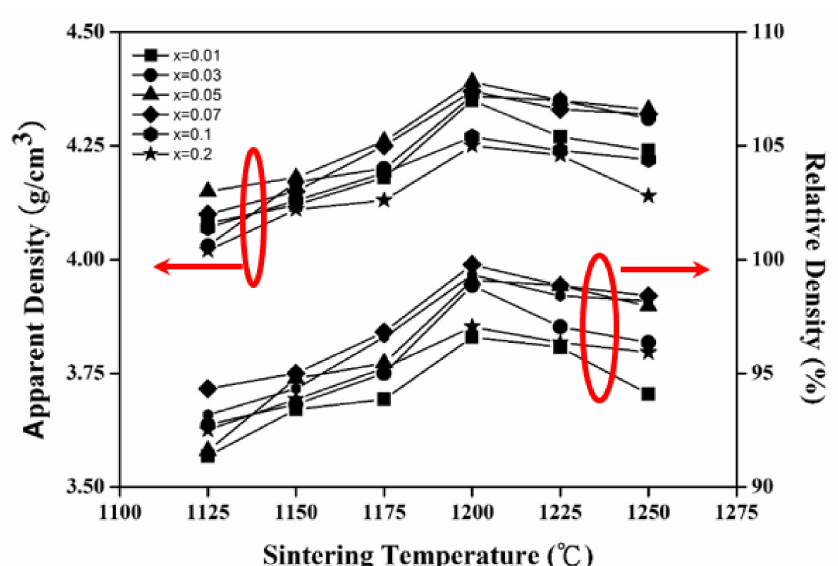
Figure 5. Dependent relationship of apparent density(g/cm 3 ) and relative density (%) of the (Mg 0.6 Zn 0.4 ) 1 − y Ni y TiO 3 ceramics with y = 0.01–0.2 under 1125–1250 ◦